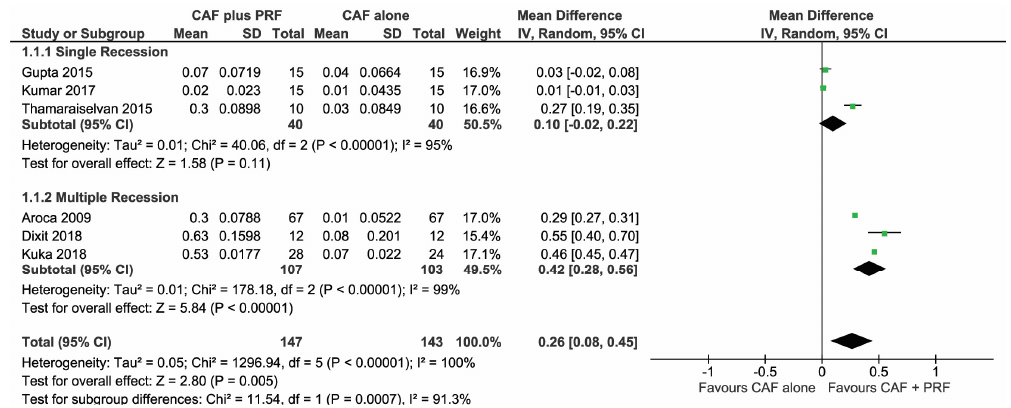
Figure 2. Comparison of change in gingival thickness (GT) between coronally advanced flap procedures (CAF) + L-PRF versus CAF alone with 6–12 months follow-up.